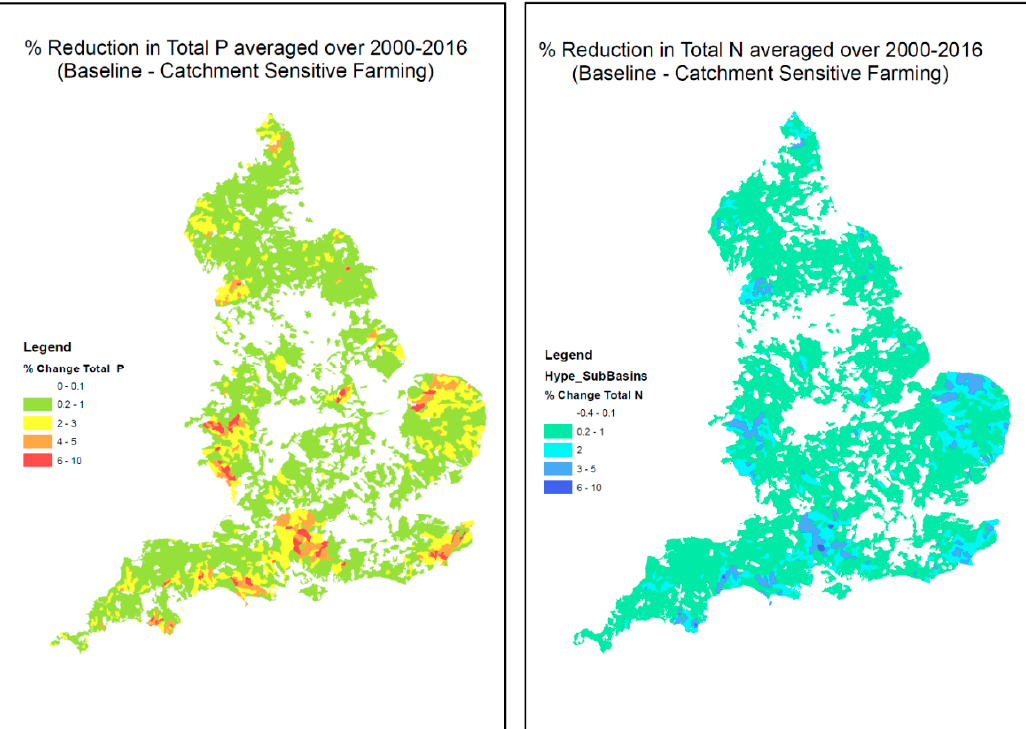
Figure 5. Predictions of percentage reduction in total phosphorus and total nitrogen loads based on the Catchment Sensitive Farming Programme and agri-environment schemes.